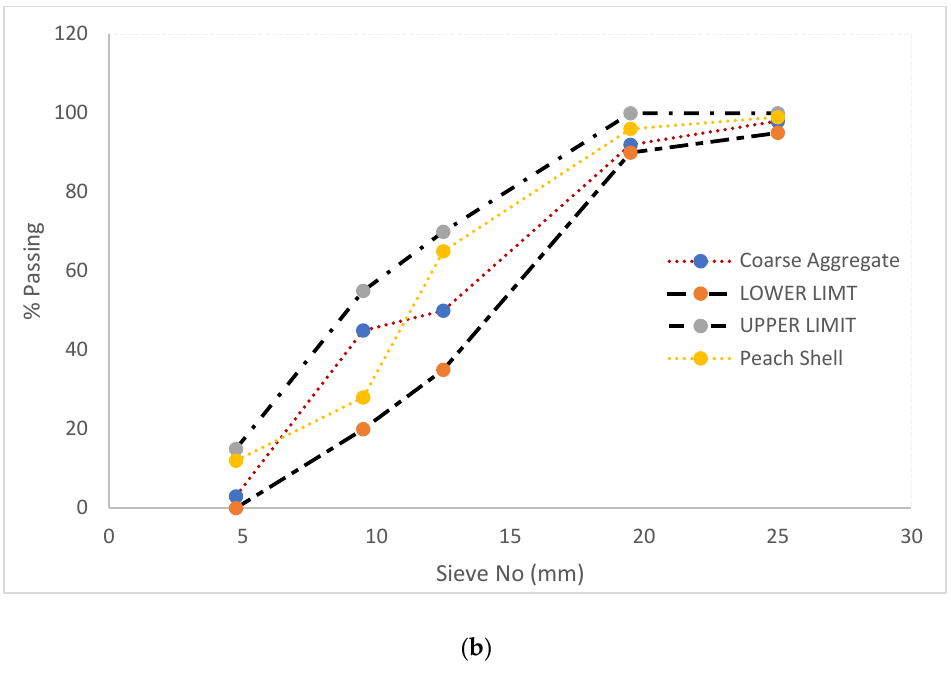
Table 2. Physical properties of peach shell, coarse and fine aggregates.